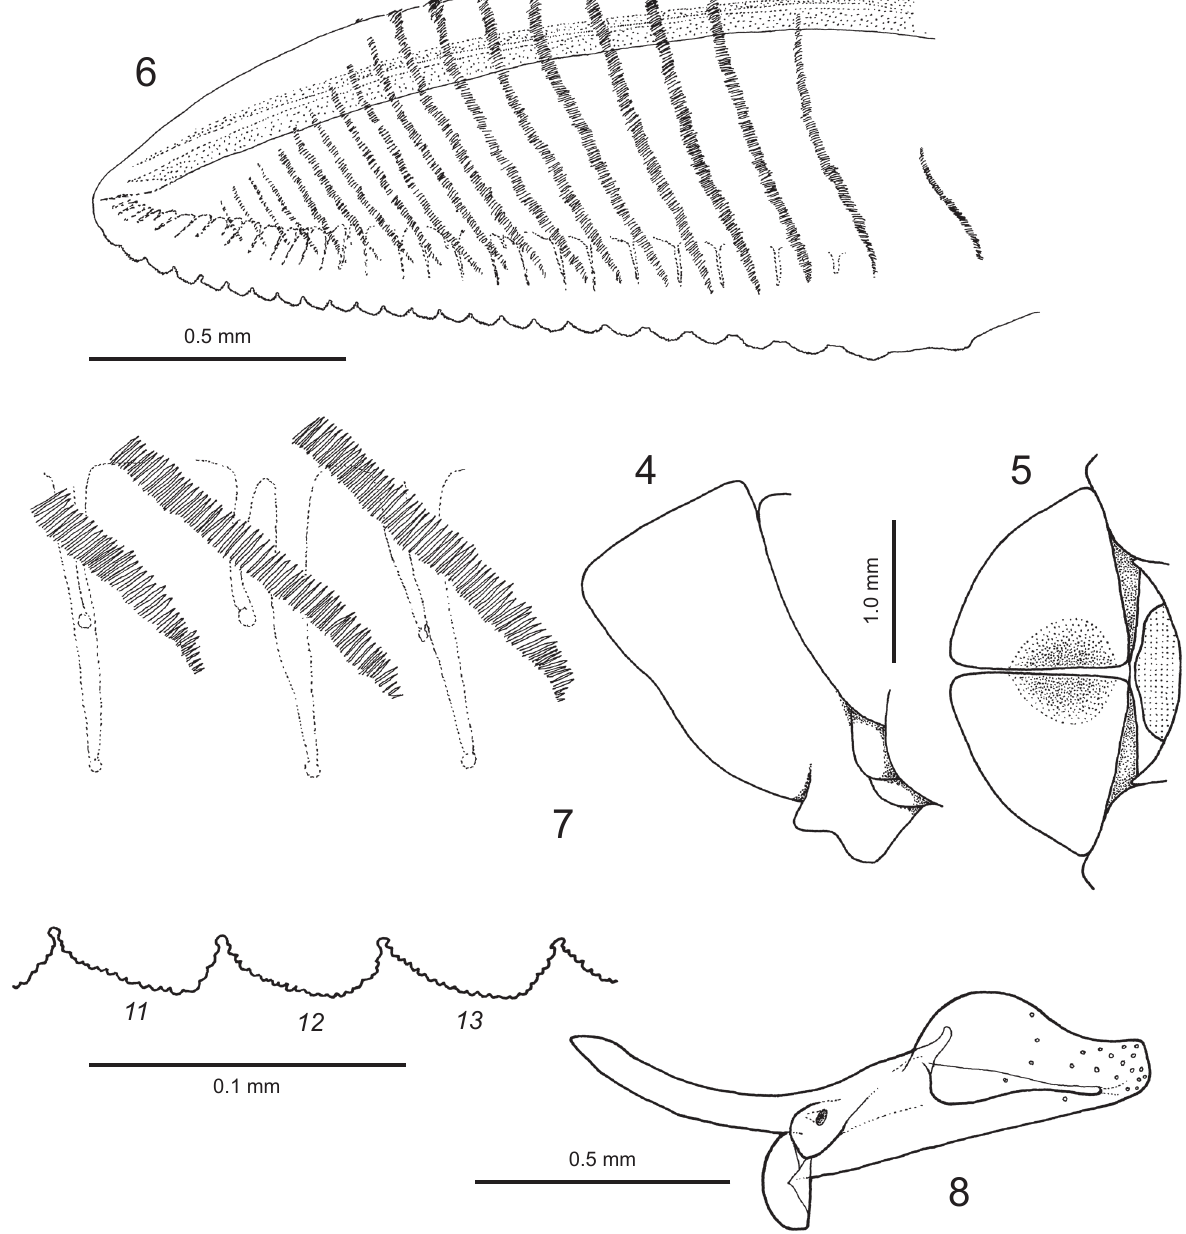
Figures 4–8. Pampsilota afer : 4. Valvulae 3 (lateral aspect); 5. Valvulae 3 (dorsal aspect); 6. Lancet; 7. Serrulae 11–13; 8. Penis valve (left, lateral